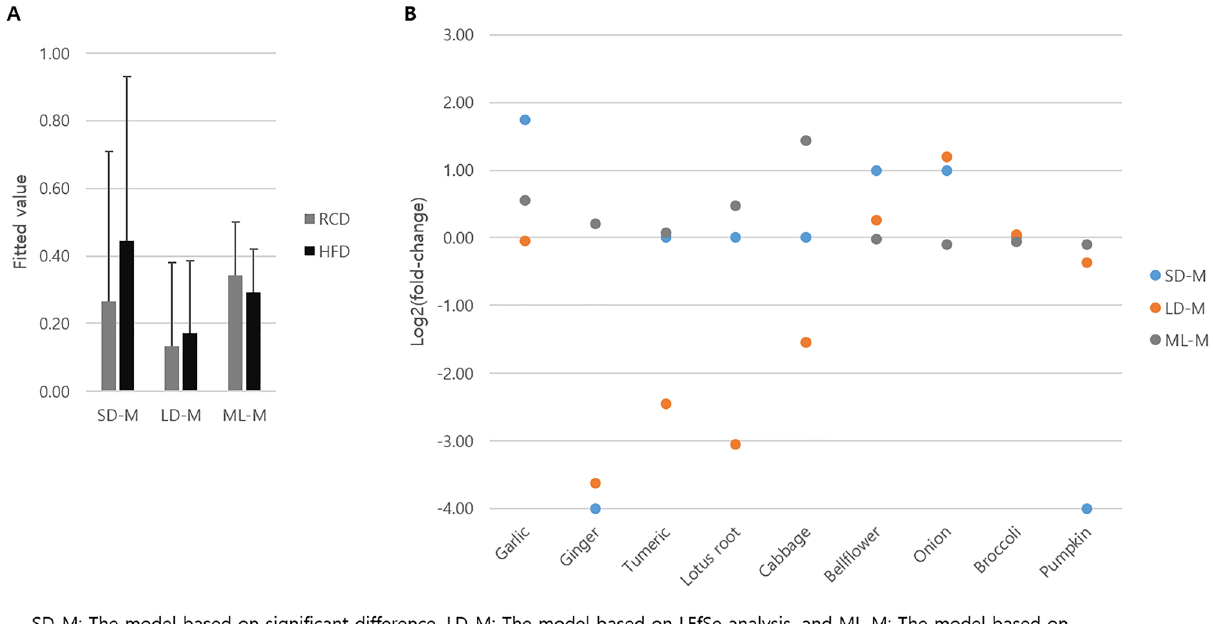
Figure 6. The predicted values of breast cancer risk in mice fed diets using diagnostic models. ( A ) Difference of fitted values between regular chow diet (RCD) and high-fat diet (HFD) and ( B ) Fold-changes between HFD and HFD + diet with garlic, ginger, turmeric, lotus root, cabbage, bellflower root, onion, broccoli, and